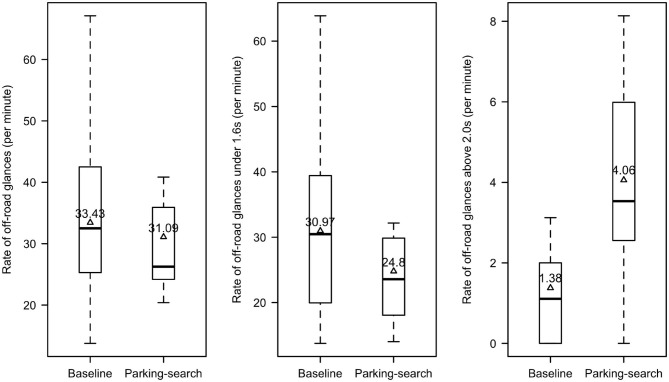
Rates of off-road glances (total, under 1.6 s, above 2 s) per minute.